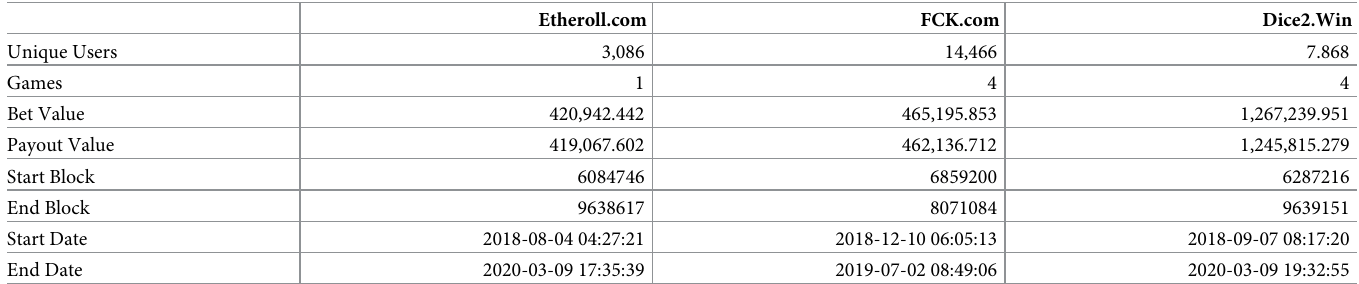
Table 2. Meta data for each application gathered as part of this study. Bet and Payout values are given in ETH, and starting and ending blocks and dates represent the time window from which transactions were gathered. All transaction data used in this study is available at